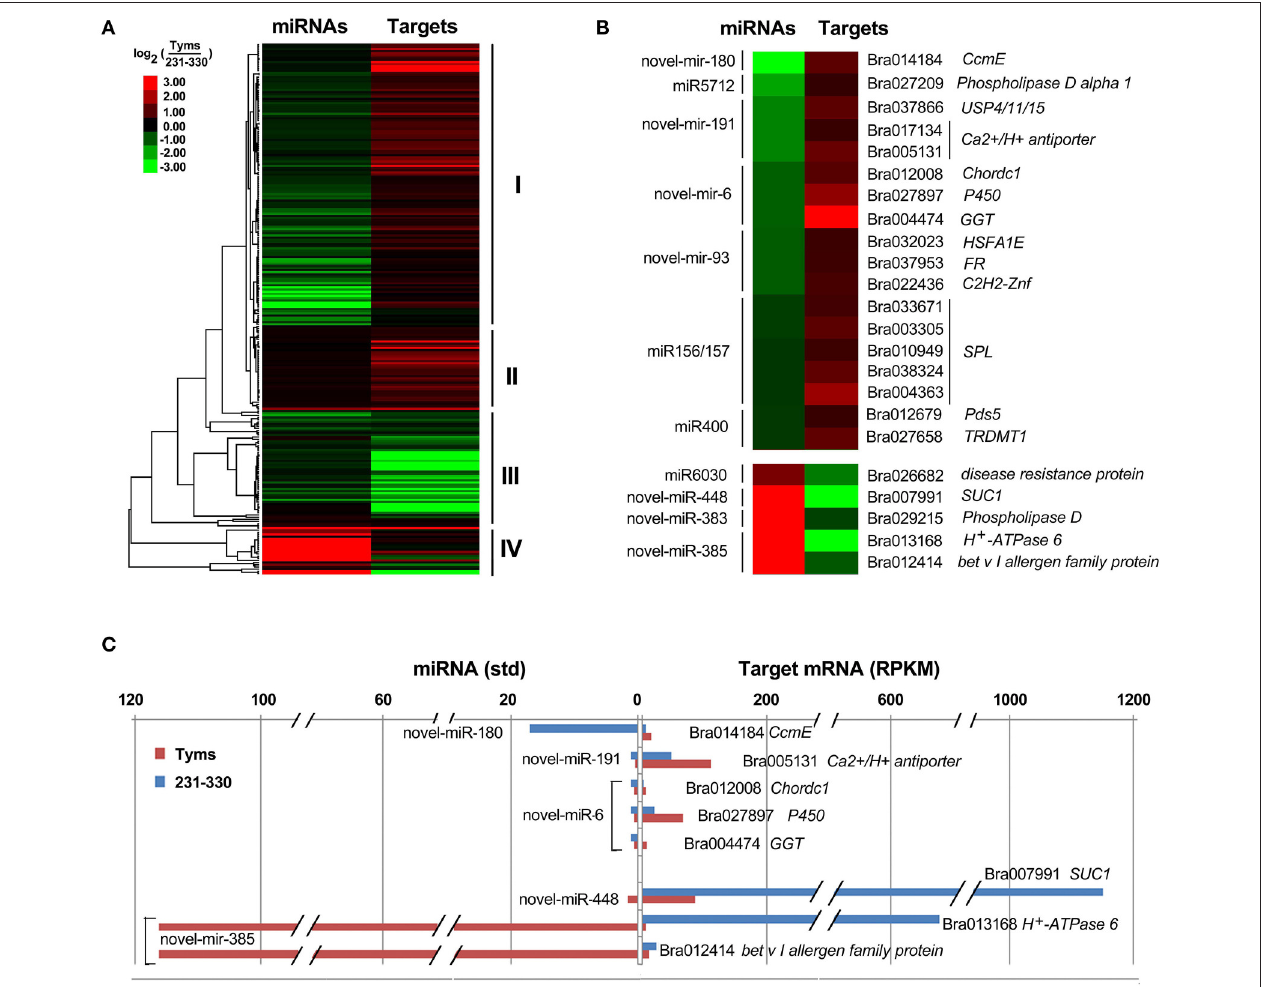
FIGURE 5 | Expression profiles of miRNA-targets. (A) Heatmap of overall expression patterns of miRNA-targets. (B) Heatmap of expression levels of miRNAs and their targets with more than 1.5-fold changes between Tyms and 231–330. (C) Bar chart of expression levels of miRNAs and their targets with more than two-fold changes between Tyms and 231–330. CcmE, cytochrome c biogenesis protein; USP4/11/15, ubiquitin carboxyl-terminal hydrolase 4/11/15; Chordc 1, cysteine/histidine-rich C1 domain-containing protein; P450, cytochrome P450; GGT, glycogenin glucosyltransferase; FR, ferric reduction oxidase 7; C2H2-Znf, C2H2 zinc finger protein 1; SPL, SQUAMOSA promoter binding protein-like; Pds5, sister chromatid cohesion protein PDS5; TRDMT1, tRNA (cytosine38-C5)-methyltransferase; SUC1, sucrose